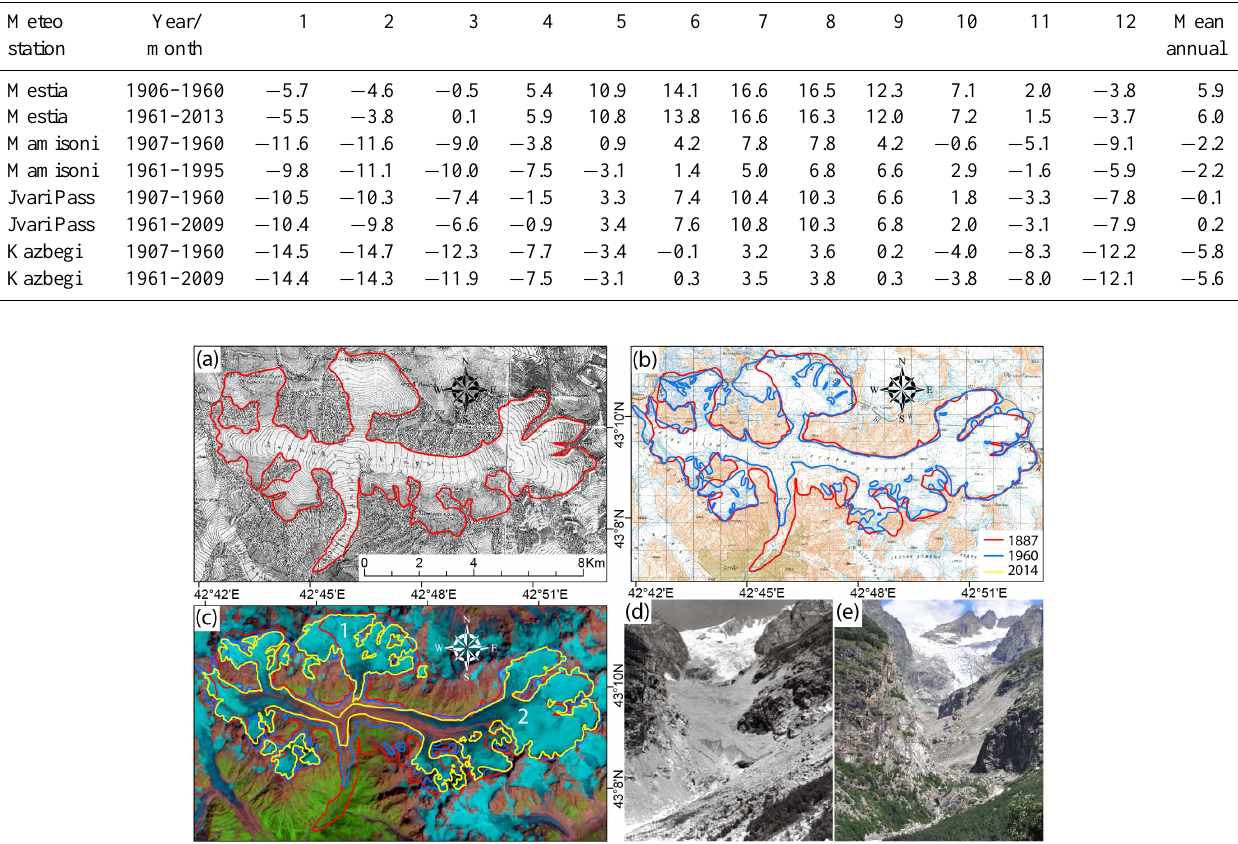
Figure 4. (a) Lekhziri Glacier, topographical map 1887; (b) topographical map 1960, (c) Landsat L8 imagery; 1: northern Lekhziri (central flow), 2: Georgia’s largest glacier Lekhziri (consisting of two flows); (d) Lekhzi Glacier terminus in 1960 (photo by Sh. Inashvili); (e) the same view in 2011 (photo by L. G.